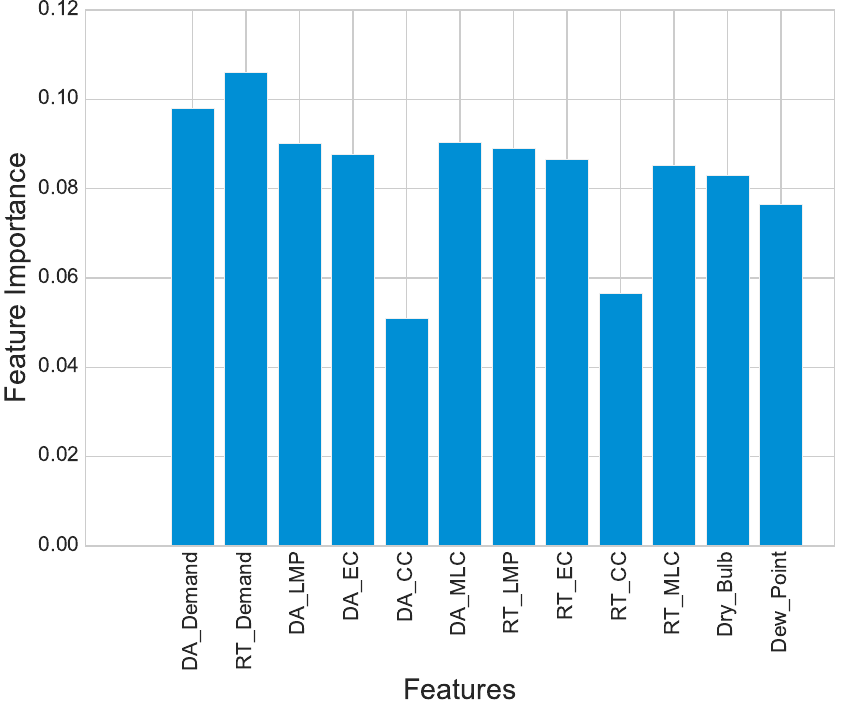
Figure 5. Feature Importance.